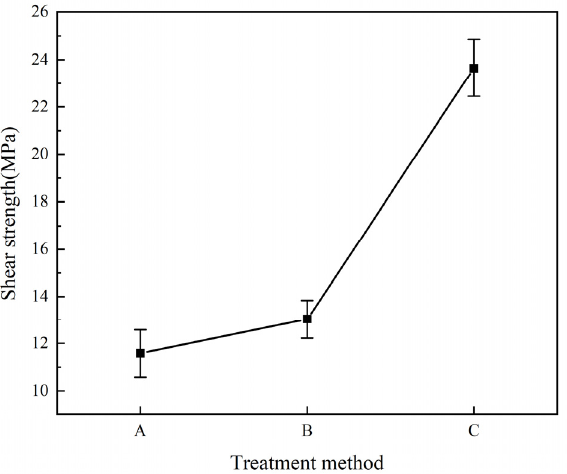
Figure 8. Shear strength curve of laminates after different treatment methods.